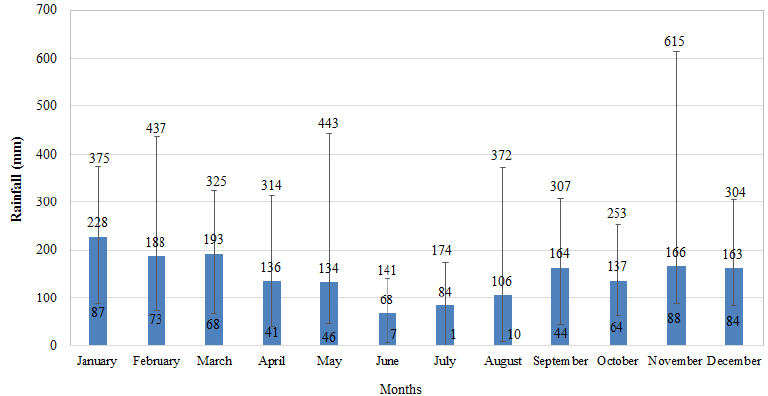
Figure 5. Average monthly rainfall in Florianópolis from 2002 to 2013, with maximum and minimum values for each month.